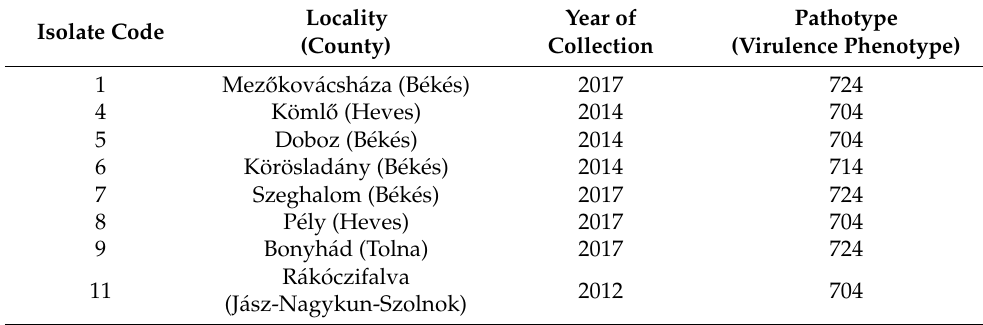
Table 1. List of Plasmopara halstedii isolates collected in Hungary (2012–2017) used in the experiment. Isolate Code